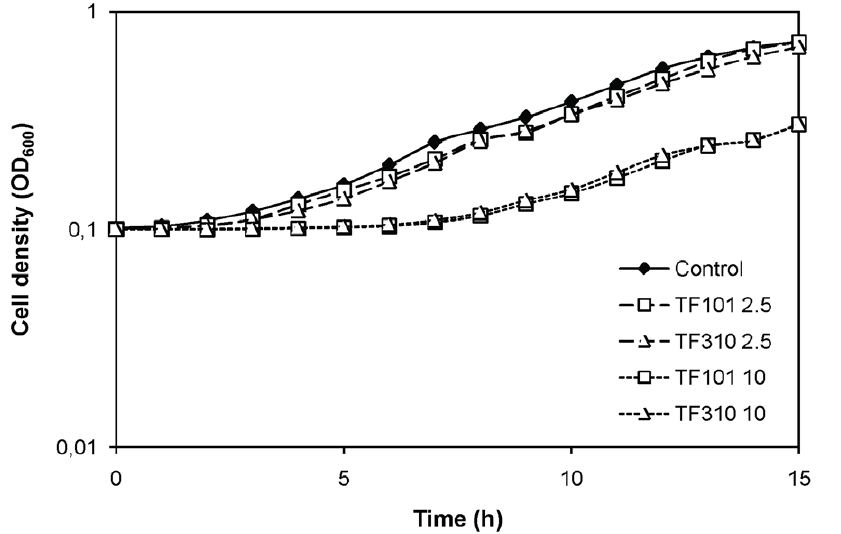
Figure 3. Growth of Vibrioharveyi BB120 in Luria-Bertani medium containing 35 g l 2 1 of synthetic sea salt, with and without the thiophenones at 2.5 and 10 m M (average of 4 replicates). Error bars are too small to be visible.